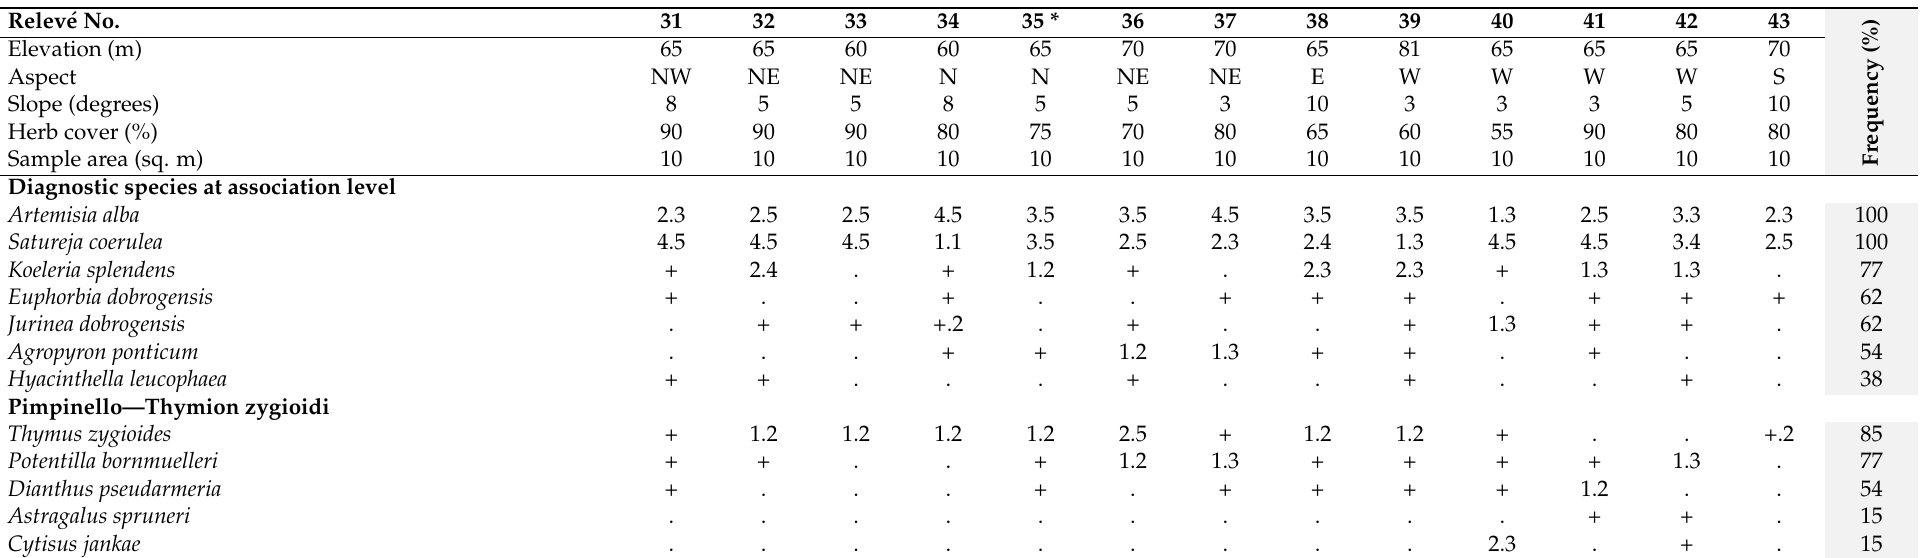
Table 4. Saturejo coeruleae—Artemisietum albae ass. nova hoc loco (* holotypus). Relev é